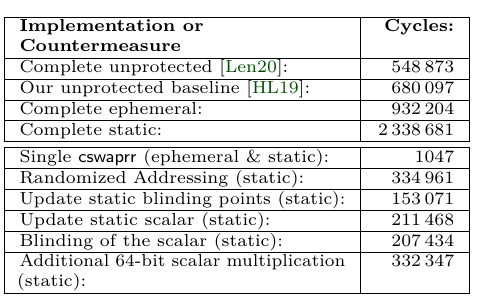
Table 1: Performance Evaluation. Table 2: Performance of Related